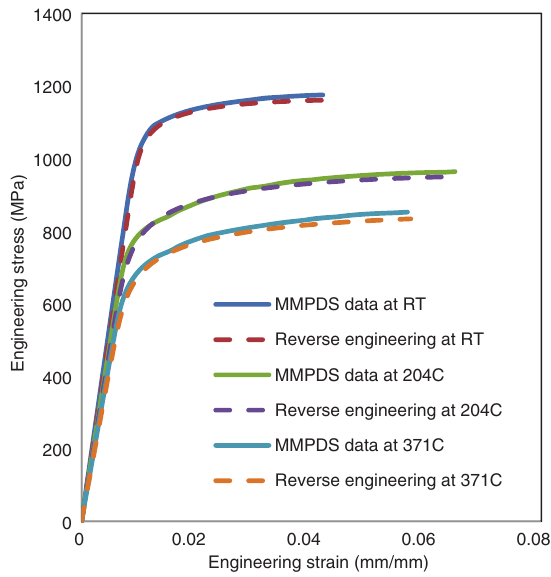
Figure 7 A comparison of MMPDs [1] and reverse engineered engi- neering stress – strain curves for Ti-64 for various temperatures.